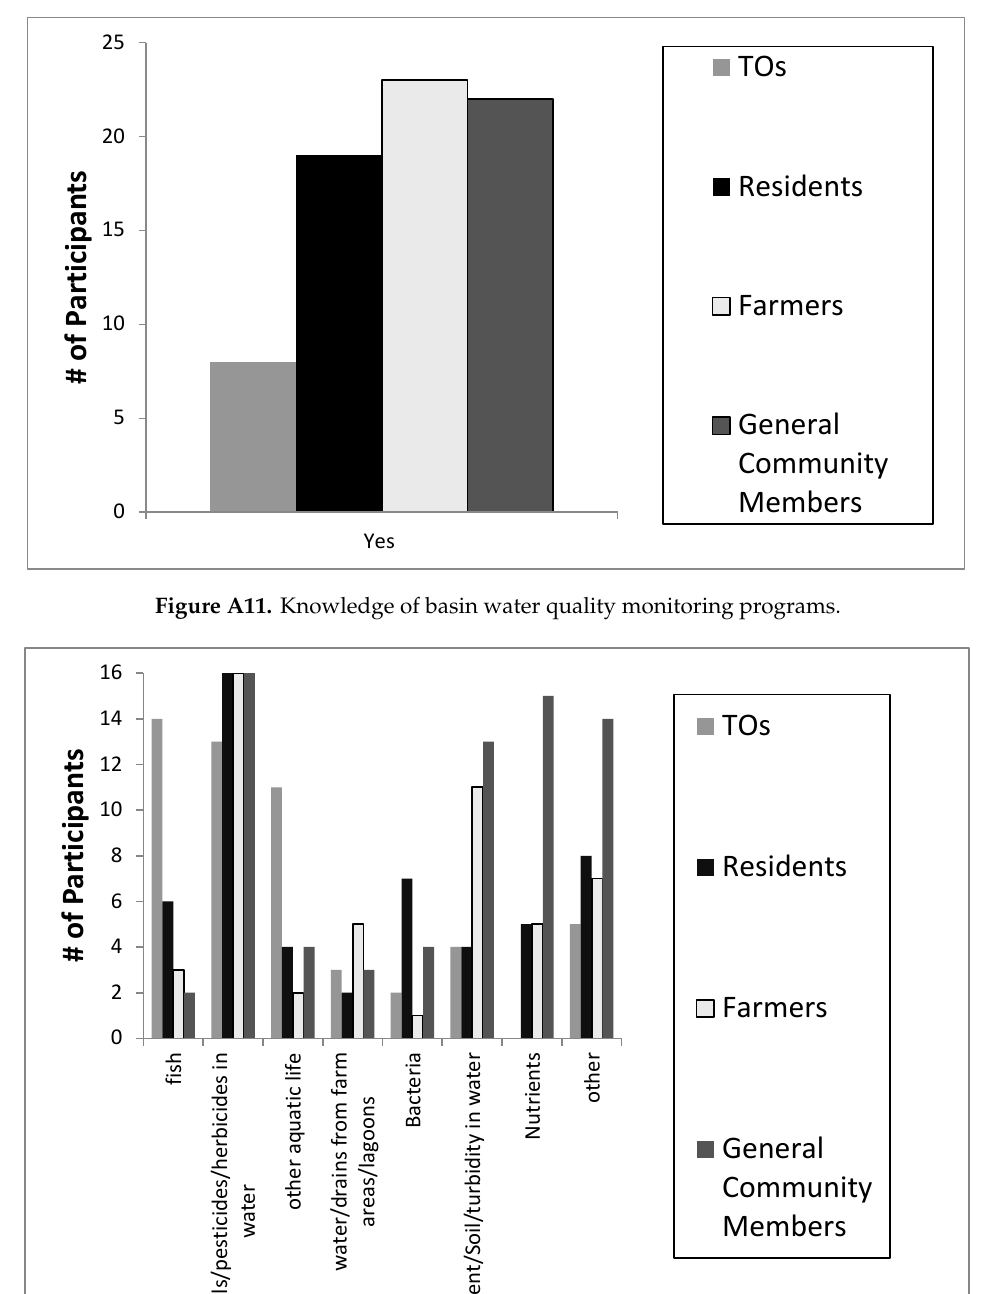
Figure A13. Suggestions for sampling locations in the basin.